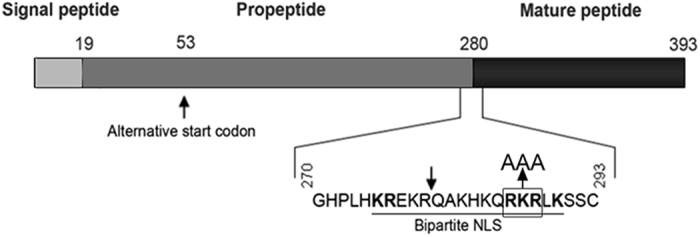
nBMP2 is synthesized by translation from a downstream alternative start codon.The BMP2 preproprotein as it is initially translated into the ER is shown schematically with the ER signal peptide (light grey), the propeptide (dark grey), and the mature peptide (black). The downward arrow indicates the site at which the BMP2 proprotein undergoes proteolytic cleavage by proprotein convertases in the Golgi to release the mature secreted peptide. Initiation at codon 53 (marked) results in cytoplasmic rather than ER translation because the ER signal peptide is absent. The protein therefore avoids proteolytic cleave and is directed to the nucleus by the bipartite nuclear localization signal (NLS) (key amino acids are in bold). The three amino acids (RKR) that were changed to alanines (AAA) to prevent nuclear localization of nBMP2 in the nBmp2NLStm mouse are shown.